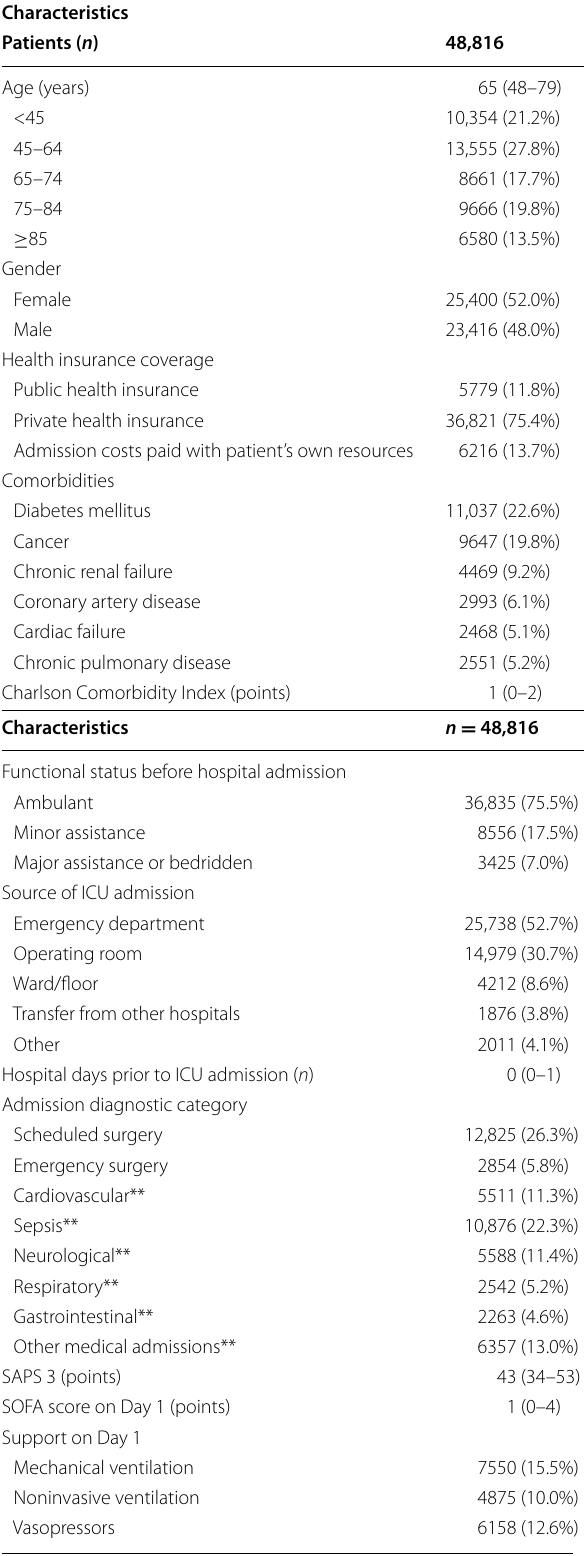
Table 2 Main patients’ characteristics and outcomes